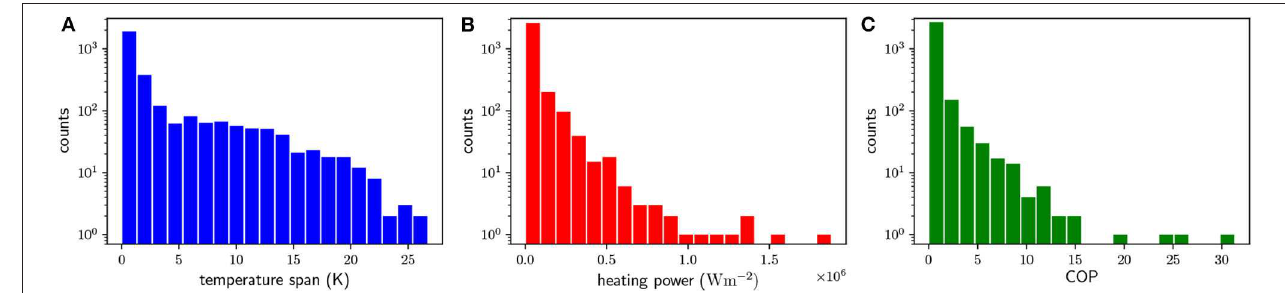
FIGURE 2 | Histogram of the 3,000 computed systems, for the (A) temperature span, (B) cooling power, and (C)